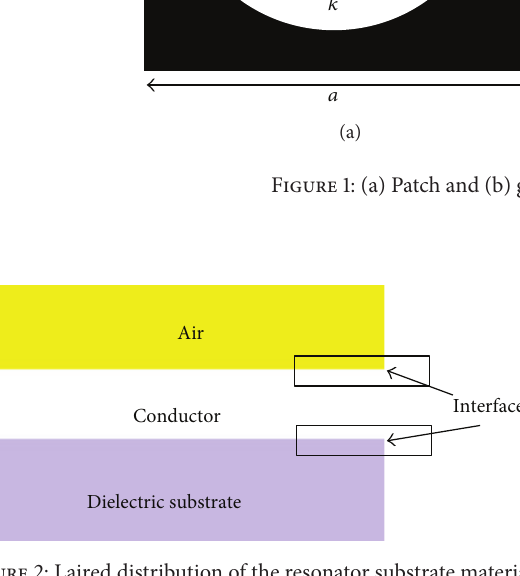
the magnetic fields. The following equation can be applied for a nondissipative